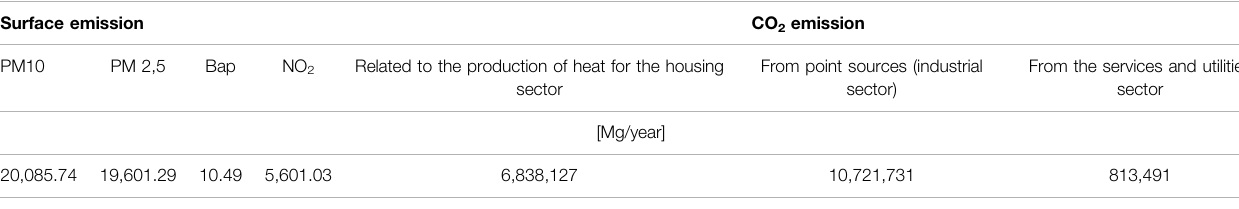
TABLE 2 | Lists of pollutant emissions in Ma ł opolska against the background of CO 2 emissions 3 .